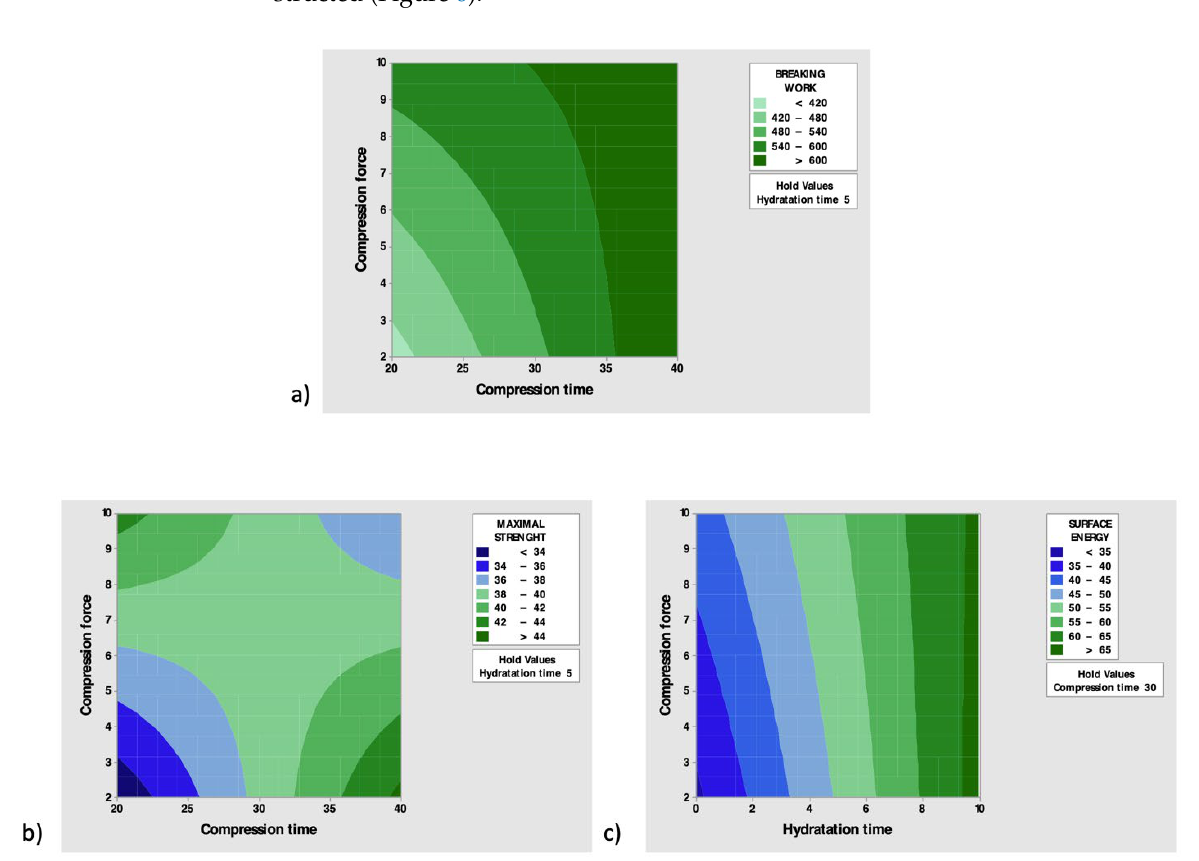
Figure 6. Contour plots of significate interactions for ( a ) breaking work, ( b ) maximal strength and ( c ) surface